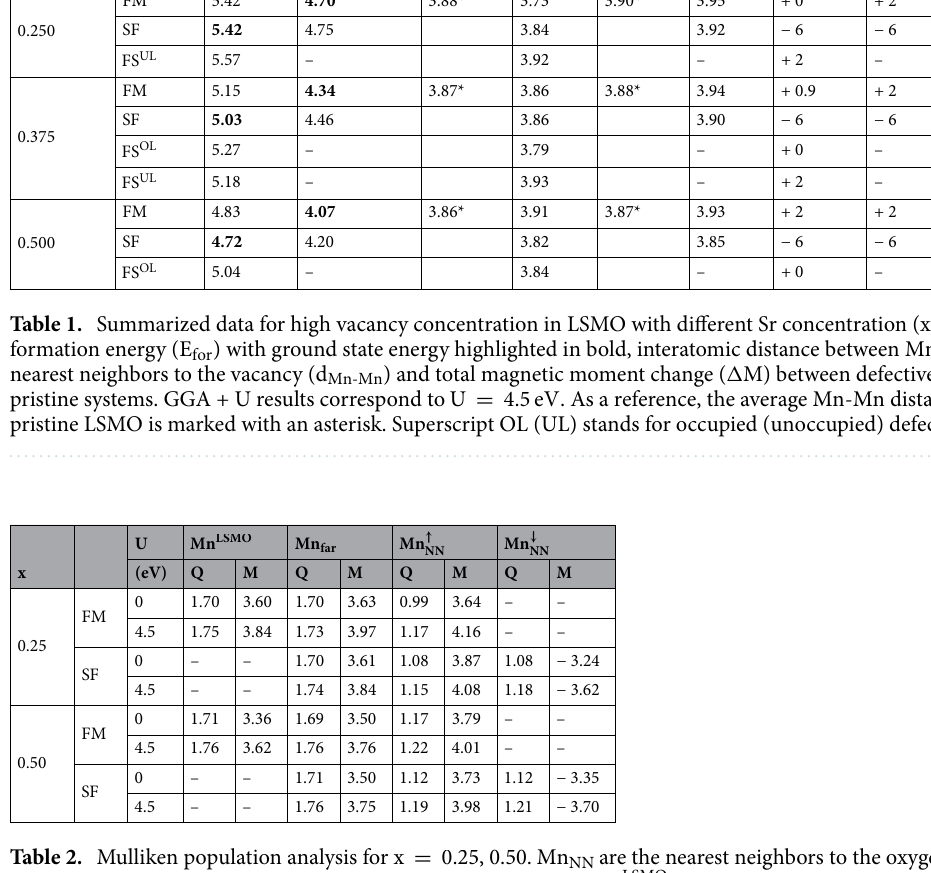
LSMO stands for a reference Mn atom of